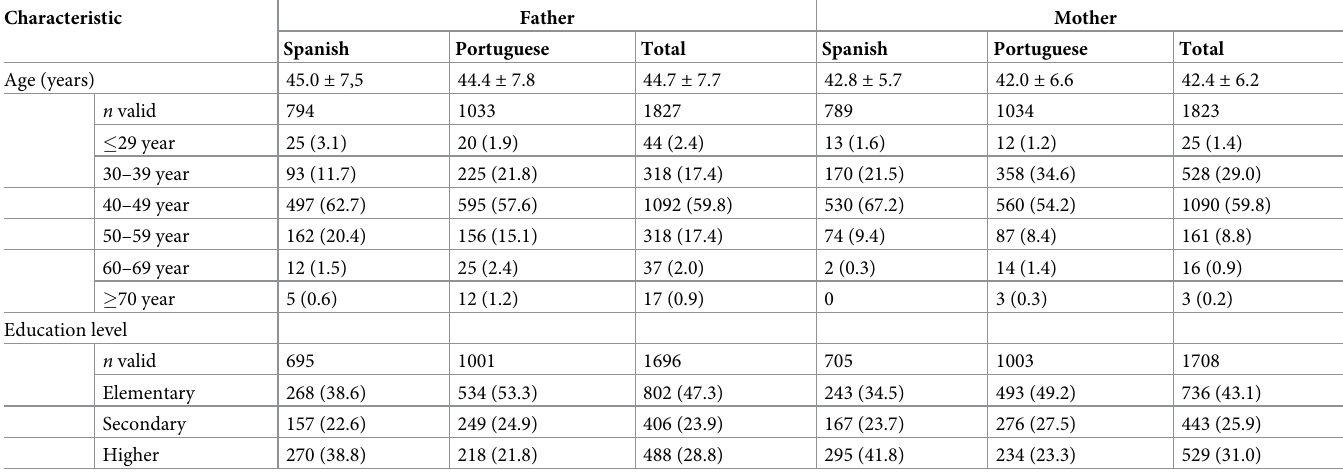
Table 1. Socio-demographic characteristics of the parents participating in the study (N = 3668).